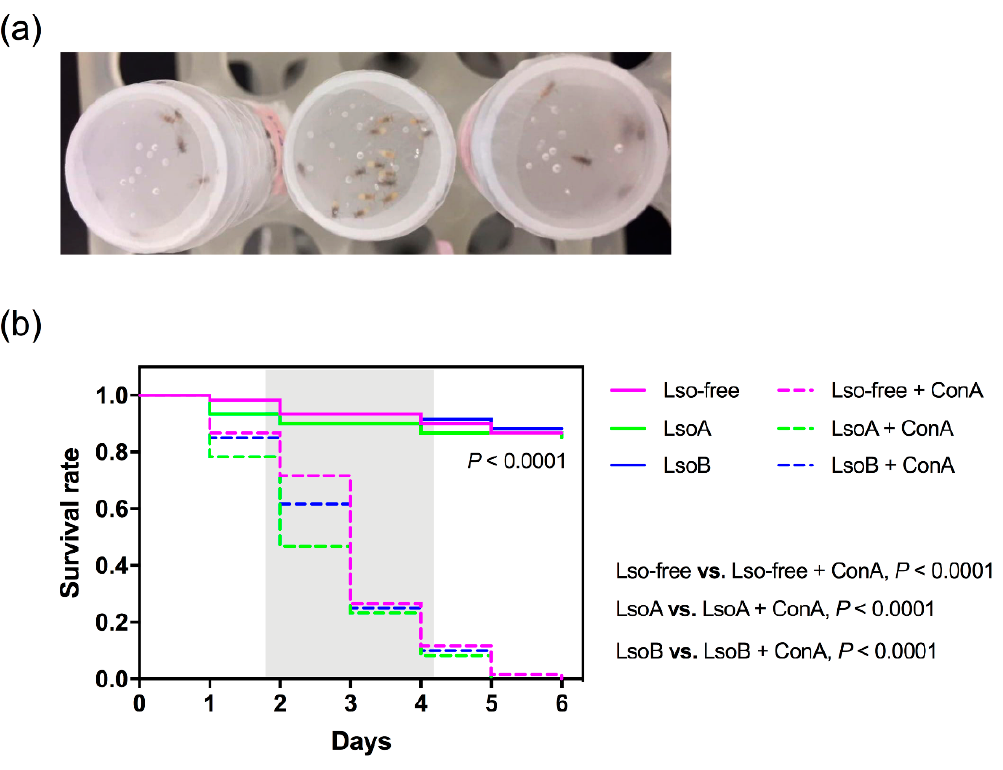
Figure 1. Feeding assays and Concanavalin A (ConA) toxicity towards potato psyllid. ( a ) Apparatus for feeding assays. The chambers were covered by two sheets of Parafilm with liquid diet between the two layers. ( b ) Mortality of Candidatus Liberibacter solanacearum (Lso)-free, LsoA-, and LsoB-infected potato psyllids following feeding on artificial diets without (control) and with ConA at the concentration of 2000 µ g / mL. p -value refers to the log-rank test. The gray region indicates a significant mortality of psyllids after feeding ConA.